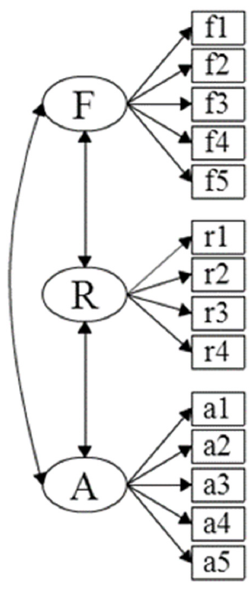
Figure 1. Model 1 or initial model.